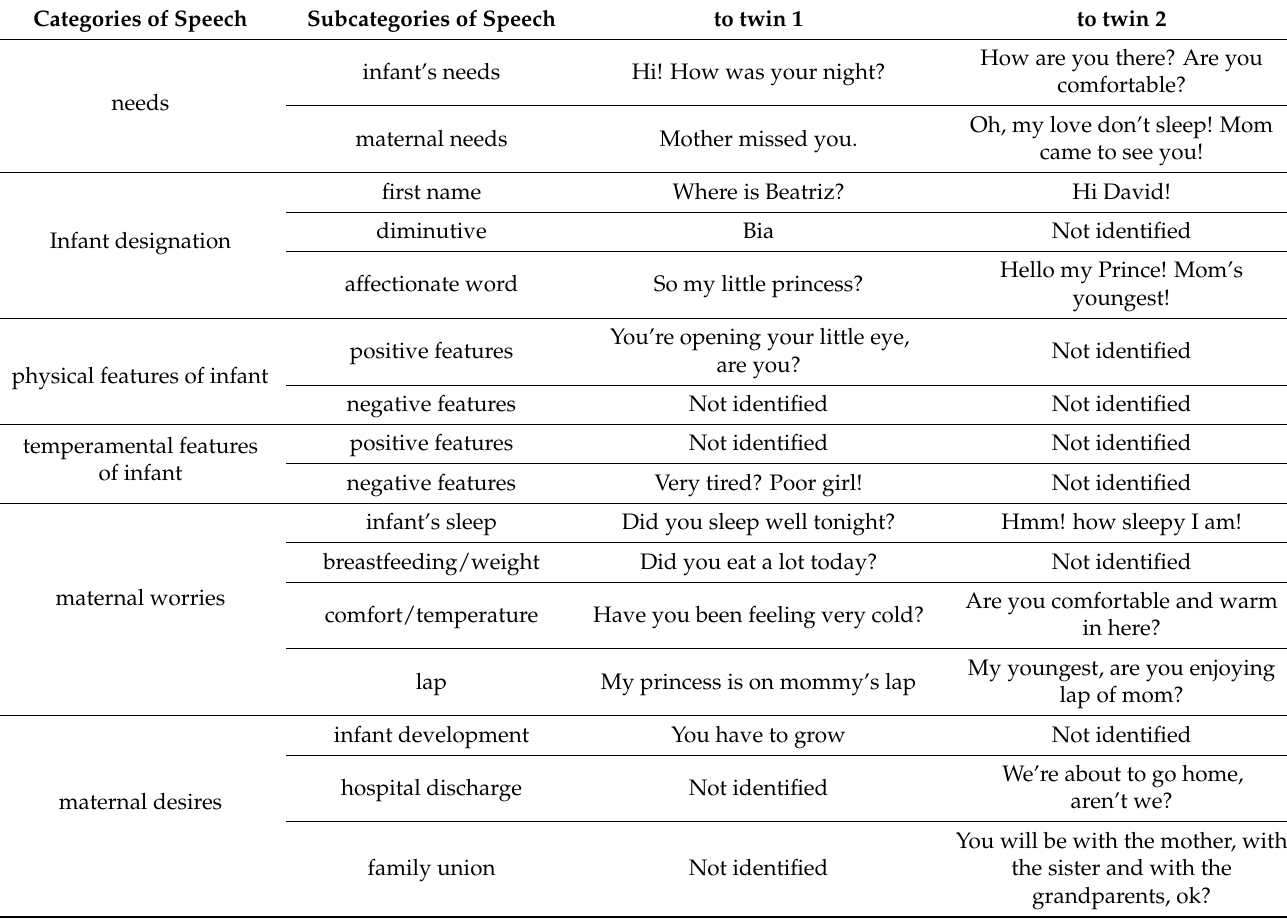
Table 5. Categories and subcategories of speech contents directed to twin 1 and to twin